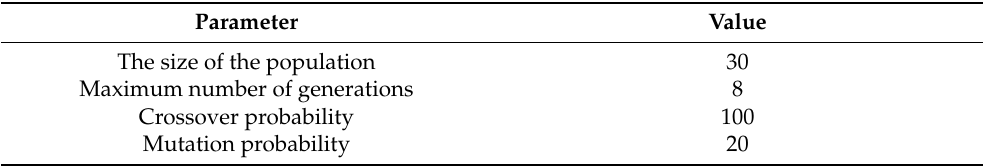
Table 4. Constant values of the modified empirical